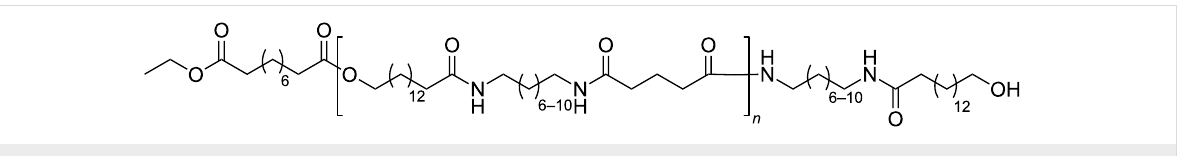
Figure 19: Poly(amide- co -ester)s comprising a terminal hydroxy moiety.